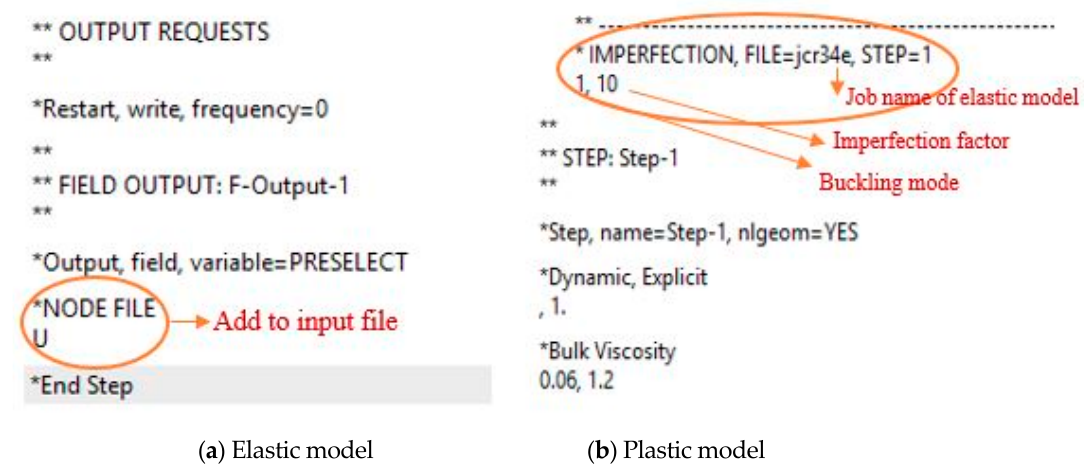
Figure 4. Parts of input file of models shown the imperfection keyword format and position (Note: * is a special character in model edit keywords)